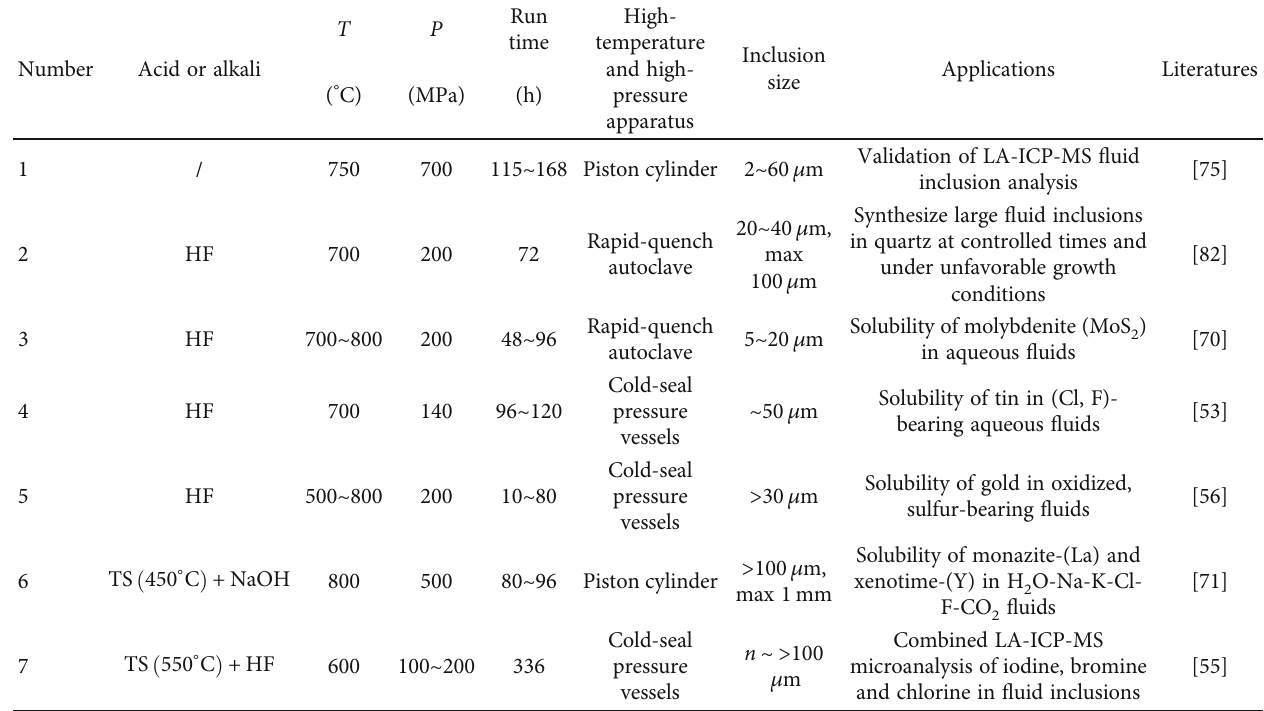
Table 3: Some typical applications of the preetching FIS technique.